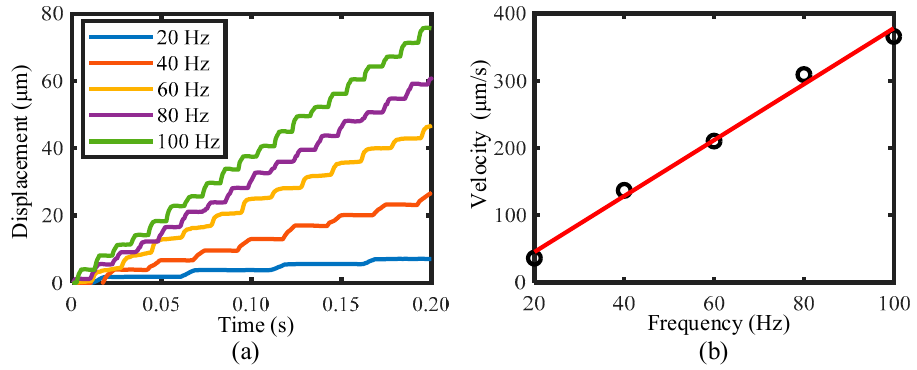
Figure 20. ( a ) Motion characteristics of the slider obtained under various driving frequencies, and ( b ) the velocity of the slider changing with the frequency under the critical relative gap.